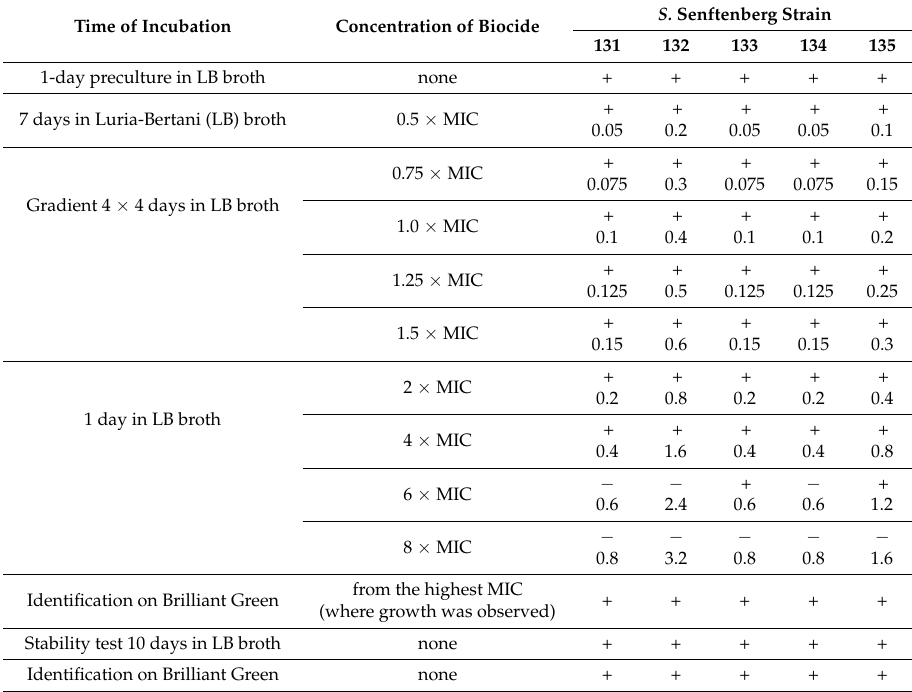
Table 1. Generation of triamine-tolerant Salmonella Senftenberg ( S. Senftenberg) variants. Time of Incubation Concentration of Biocide